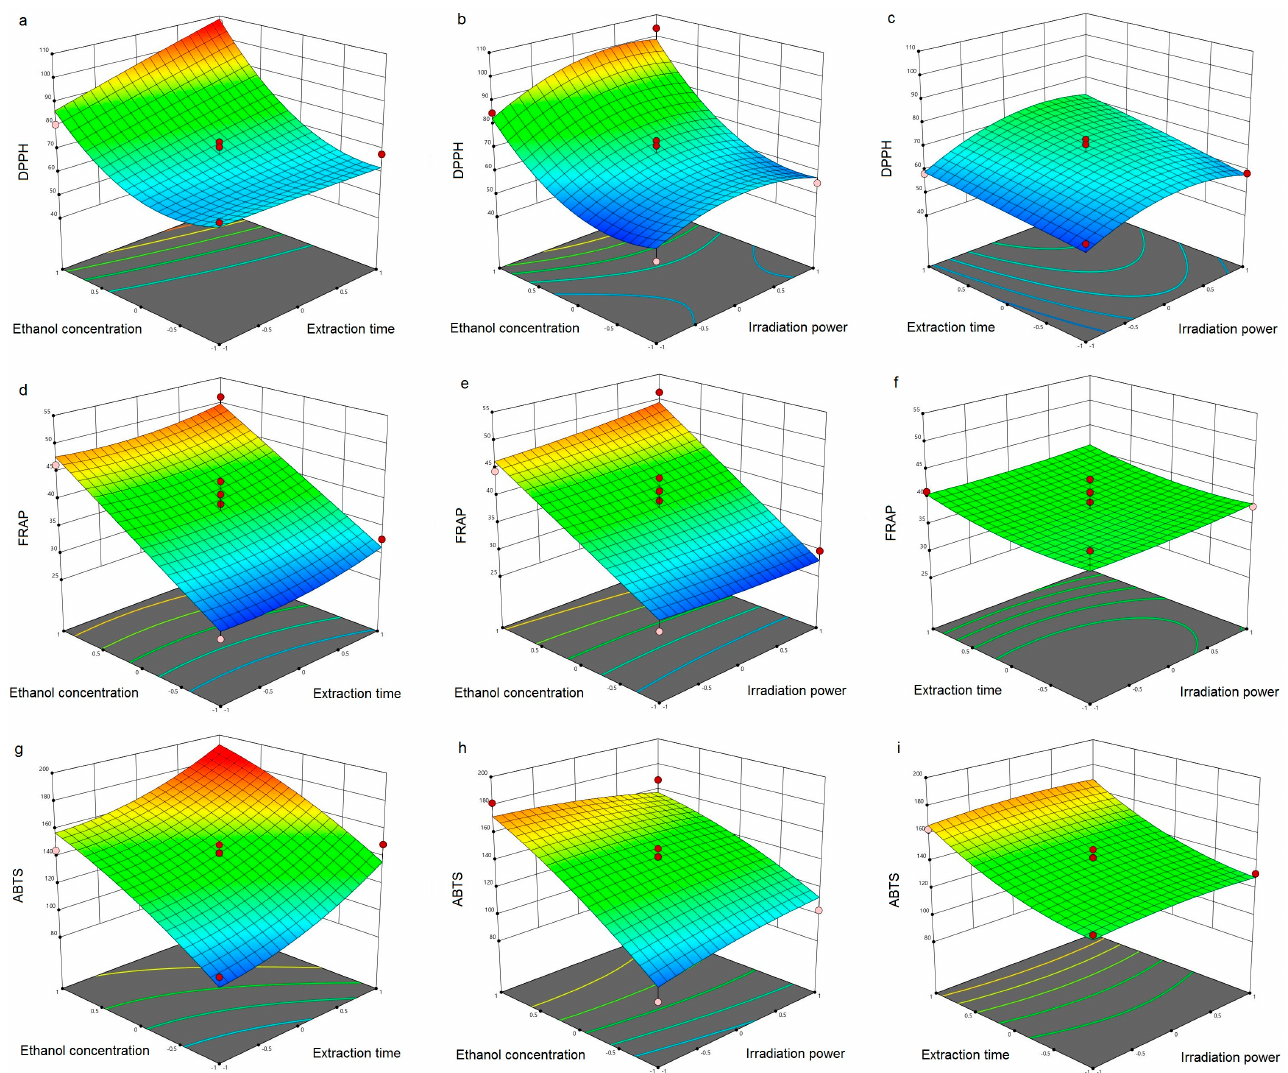
Figure 1. Response surface plots showing combined effect of investigated independent variables on: ( a – c ) DPPH; ( d – f ) FRAP; and ( g – i ) ABTS.